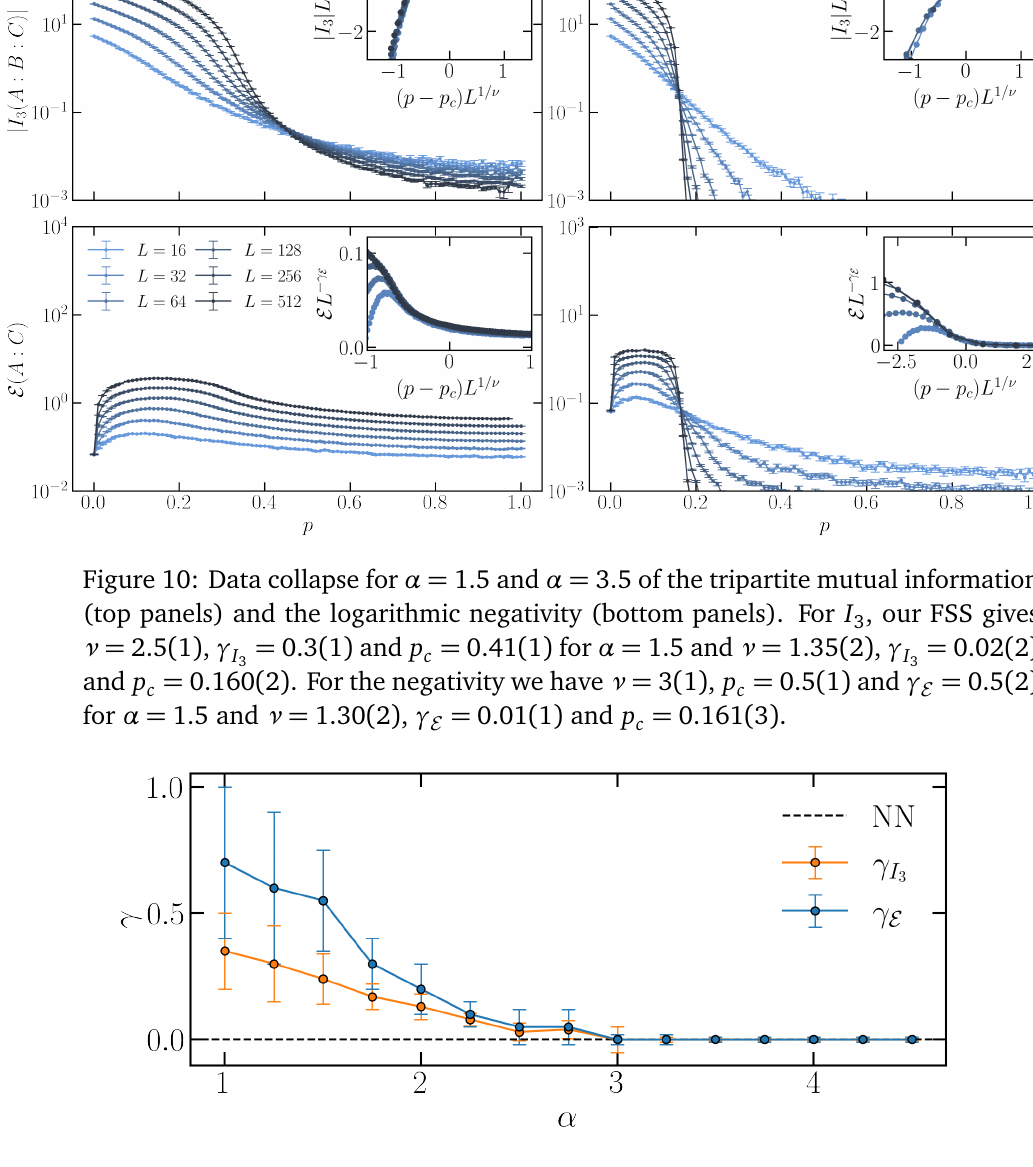
Figure 11: Scaling dimension of the logarithmic negativity and of the tripartite mu- tual